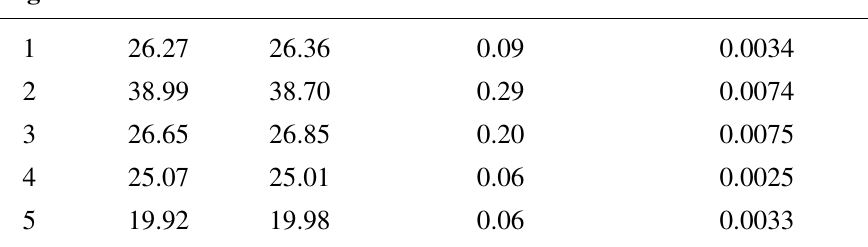
Table 2. Comparison of building height estimates between image-based method and story- based method.